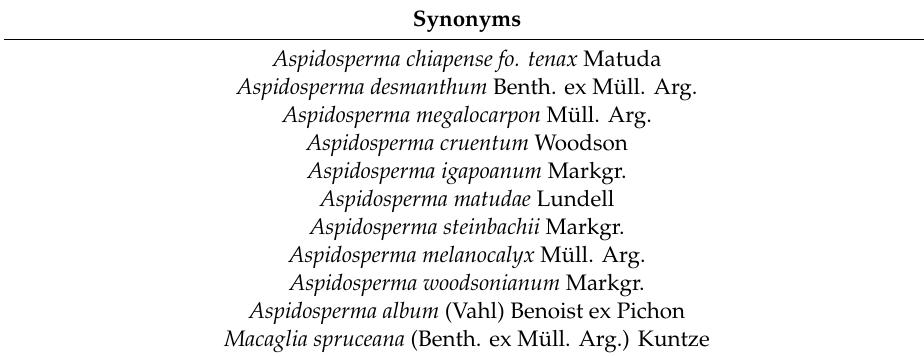
Table 1. Synonyms of Aspidosperma spruceanum Benth. ex Müll. Arg. Retrieved from Tropicos.